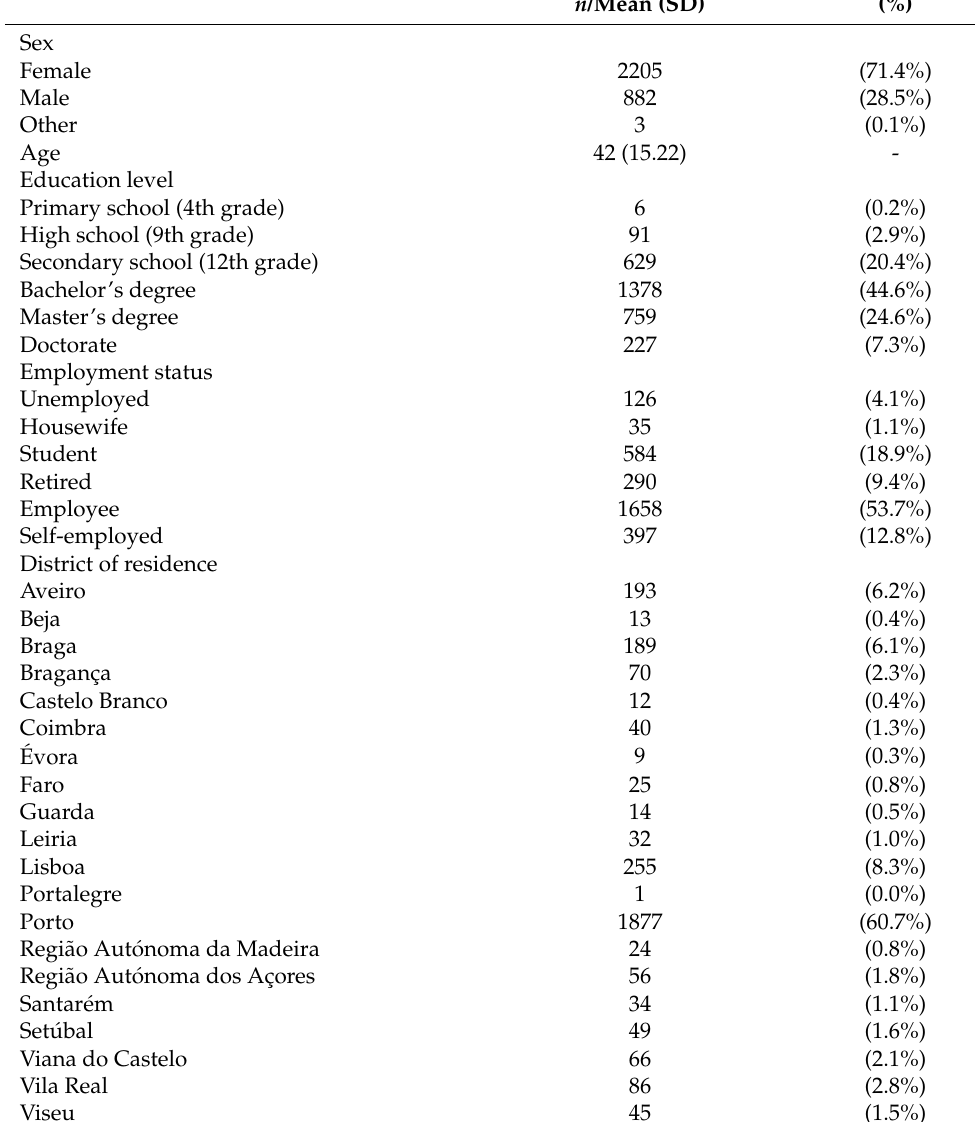
Table 1. Sociodemographic characteristics of the sample ( n =